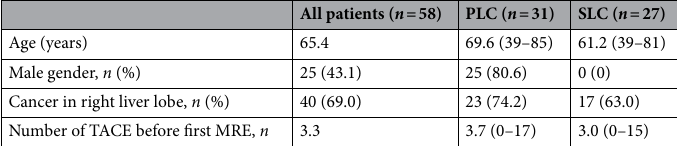
Table 1. Baseline characteristics.